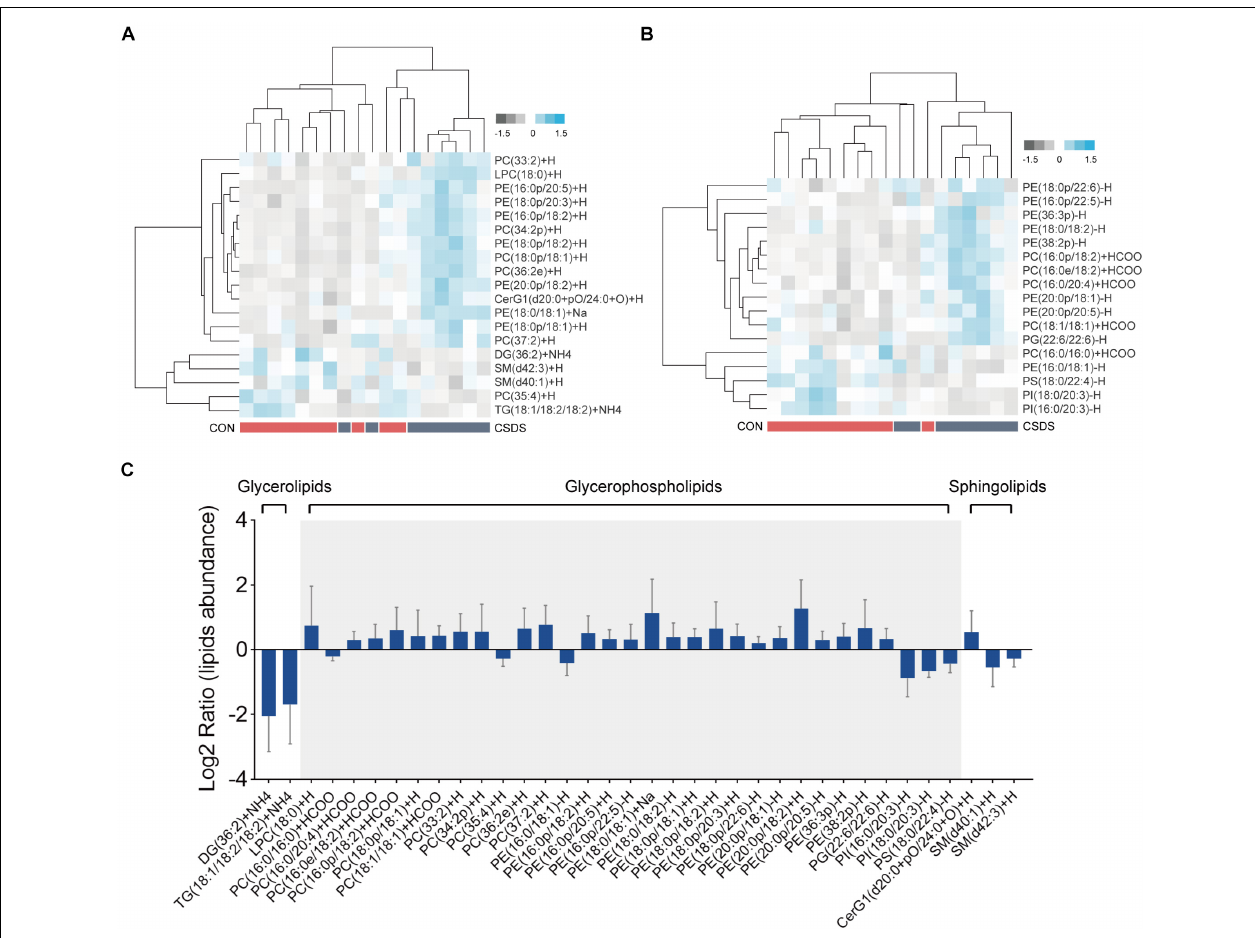
FIGURE 4 | Differential lipids identified in the colon tissues between the control and CSDS mice. (A) Heatmaps of 19 differential lipids identified in the positive mode and (B) 17 differential lipids identified in the negative mode. (C) These differential lipids belonged to glycerolipids, glycerophospholipids, and sphingolipids categories, of which most (31/36) were glycerophospholipids. CON, mice in the control group; CSDS, mice in the CSDS